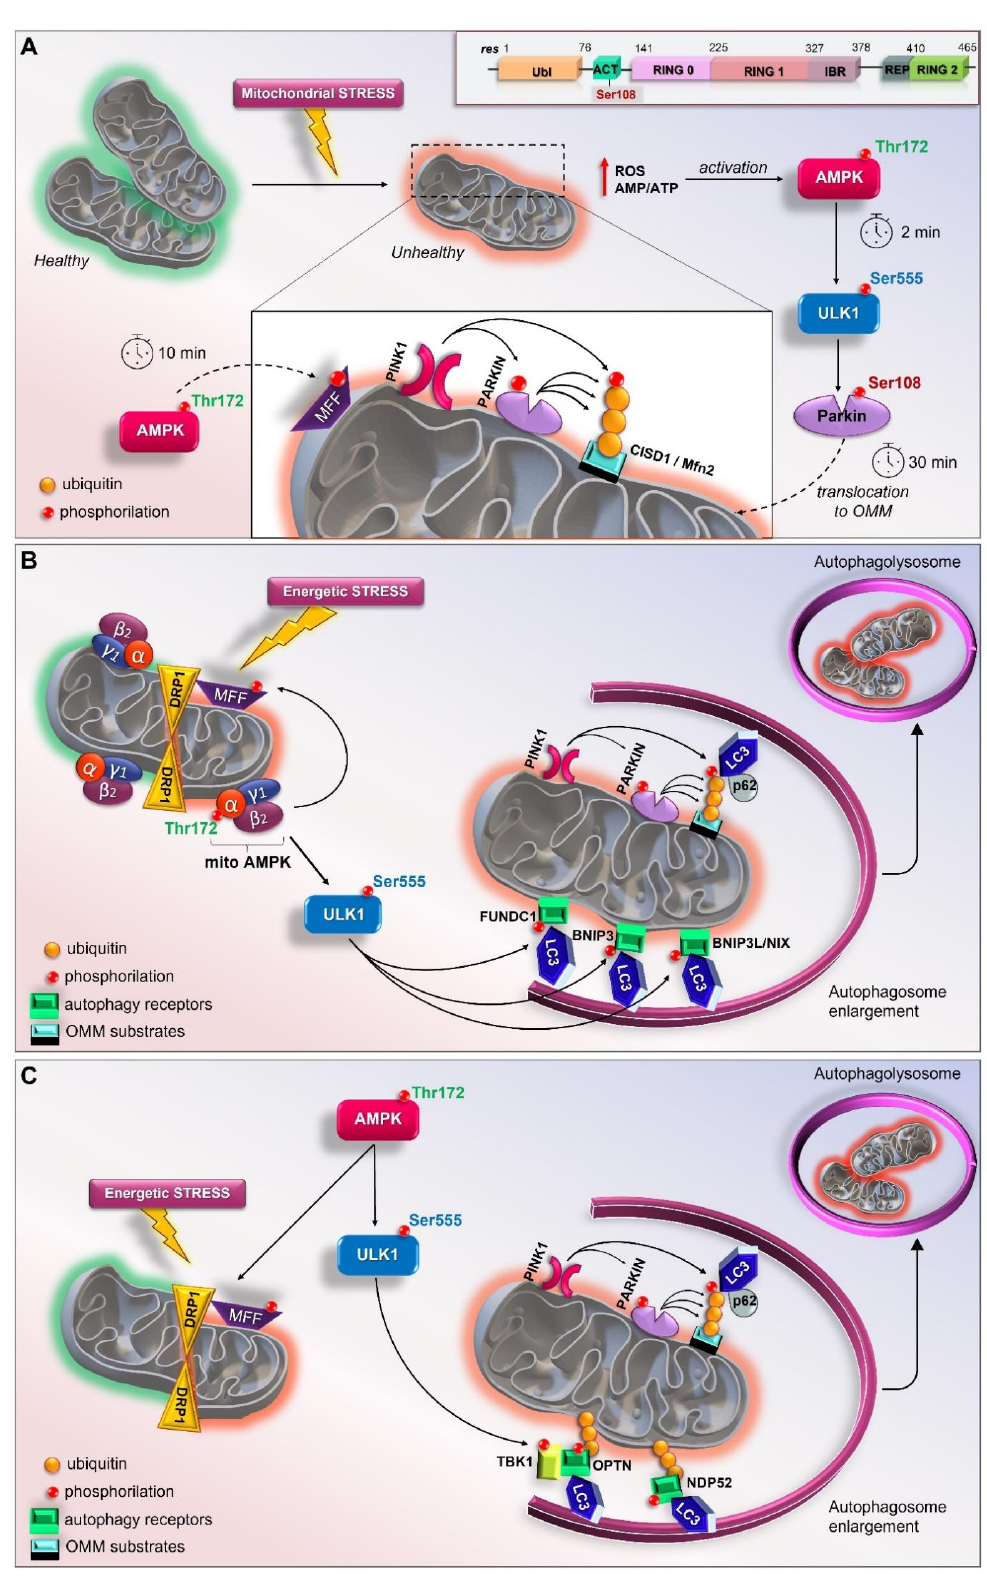
Figure 2. New current models of AMPK/ULK1-mediated mitophagy. ( A ) Top, schematic representation of primary structure of Parkin showing ACT element with Ser108 residue. In mouse livers and